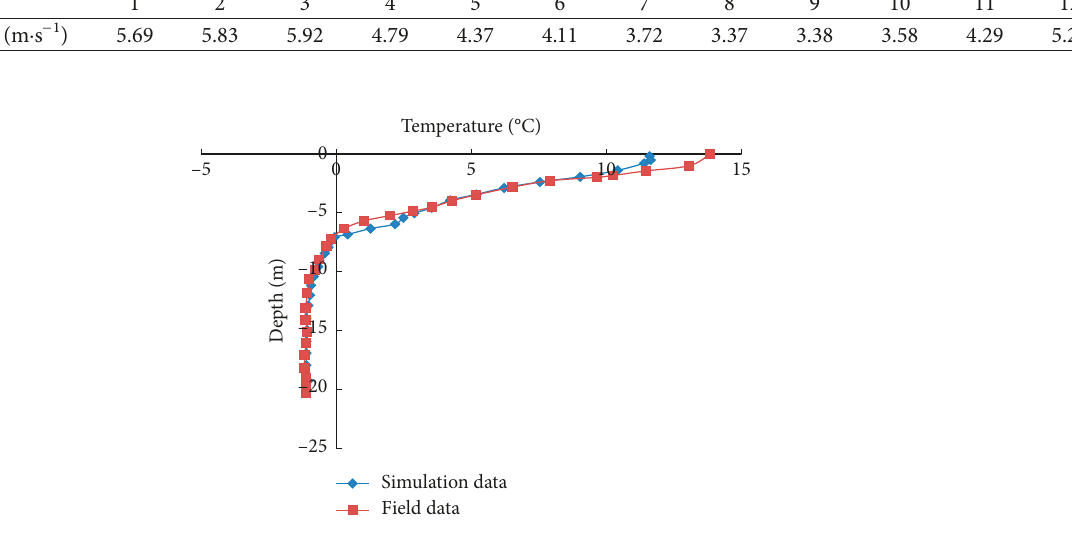
Figure 7: Comparison between calculated and measured temperature data in September.